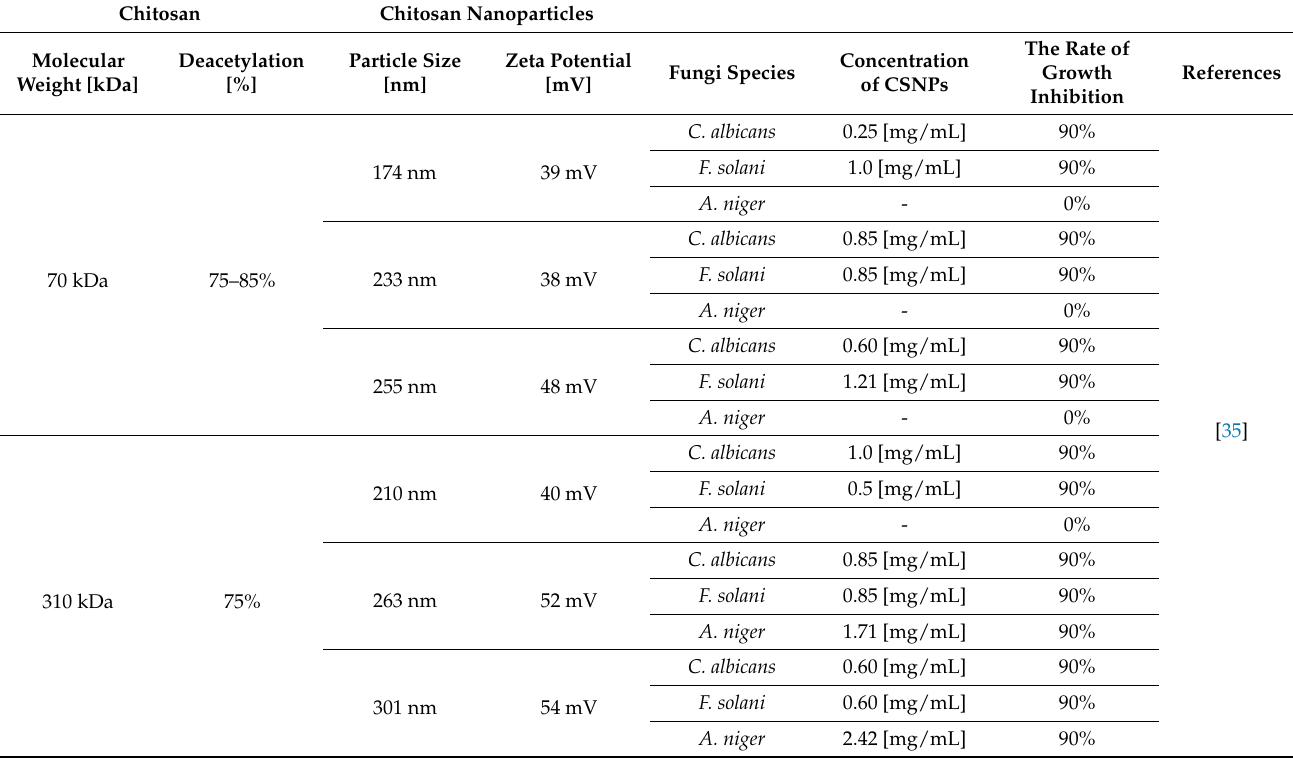
Table 1. Parameters of chitosan nanoparticles and their antifungal activity. Chitosan Chitosan